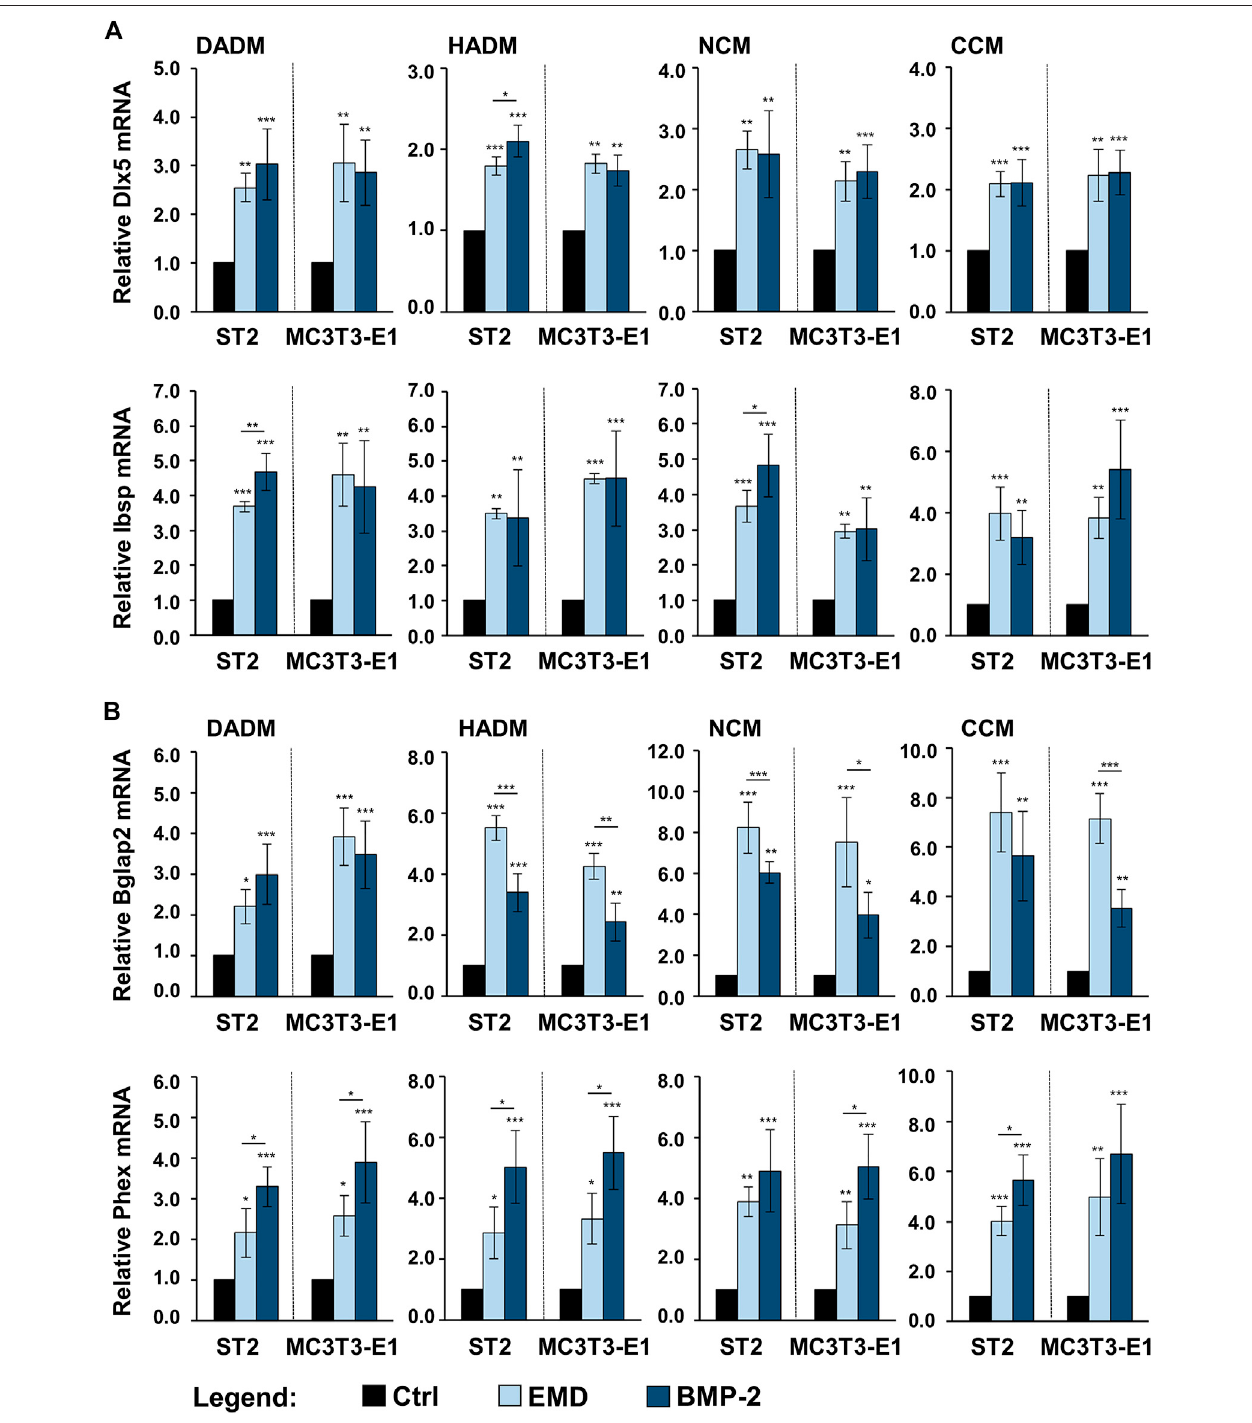
FIGURE 7 | Enhancing effect of collagen-based matrices biofunctionalized with EMD or rBMP-2 on the expression of genes characterizing intermediate and late stages of osteogenic differentiation. Each of the two osteoprogenitor cell lines, ST2 and MC3T3-E1, were cultured on DADM, HADM, NCM, or CCM collagen-based matrices under three different conditions: 1) control condition (Ctrl), consisting of cells grown on native/uncoated matrices, 2) cells grown on matrices coated with EMD, and 3) cells grown on matrices coated with rBMP-2. For conditions 2) and 3), collagen matrices were coated for 10 min at room temperature in serum-free DMEM containing 1 mg/ml of EMD or 100 ng/ml of rBMP-2, respectively, followed by extensive wash of the matrices as described in the Materials and Methods section. Cells weregrown under theabove listed conditions for 3 days before total RNA wasextractedand analyzed by qRT-PCR for the expression ofDlx5 and Ibsp (A) , Bglap2and Phex (B) .ValuesnormalizedtoGapdhareexpressedrelativetothevaluesoftherespectivecontrolcells.Means ± SDfromfourindependentexperimentsperformedwith each of the two cell lines and signi fi cant differences to the control unless otherwise indicated, *** p < 0.001, * p < 0.01, * p < 0.05 are shown.